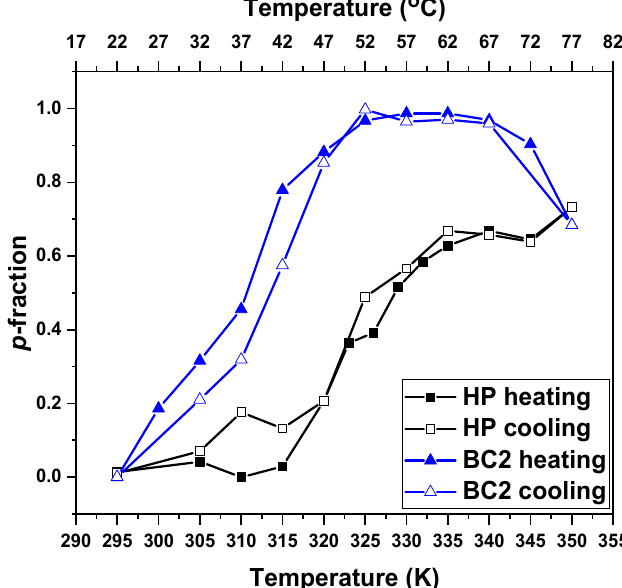
Figure 8. Hydrodynamic radius ( R H ) of the block copolymer NPs (BC1, BC2, and BC3) in water (c = 2.5 mg·mL − 1 ) measured as a function of temperature.